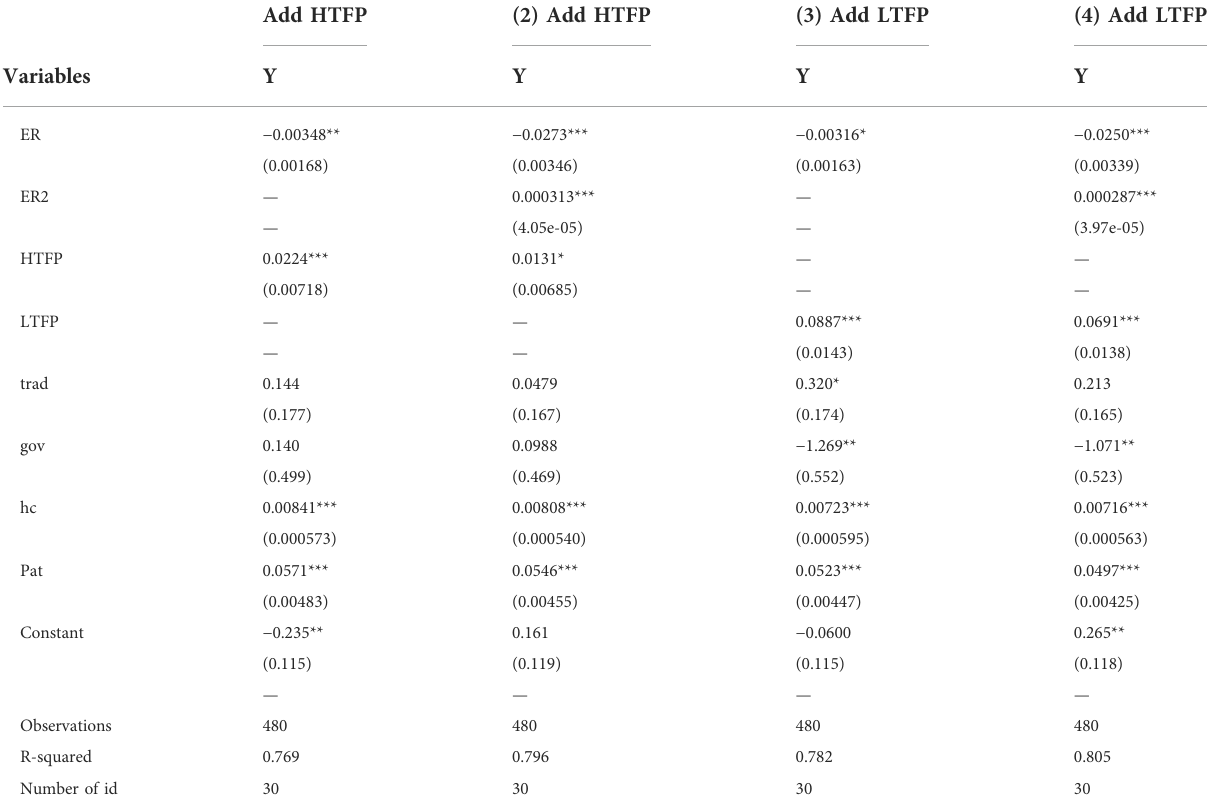
TABLE 6 Regression Results of Model